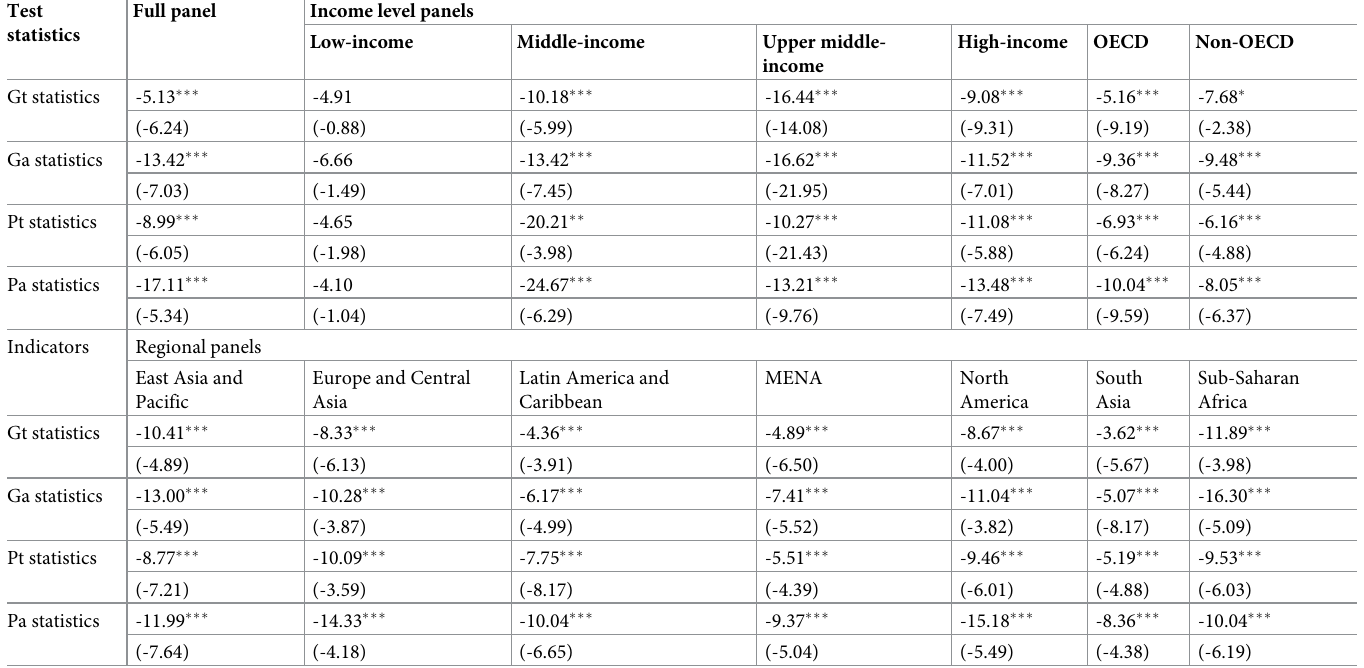
Table 2. Panel cointegration